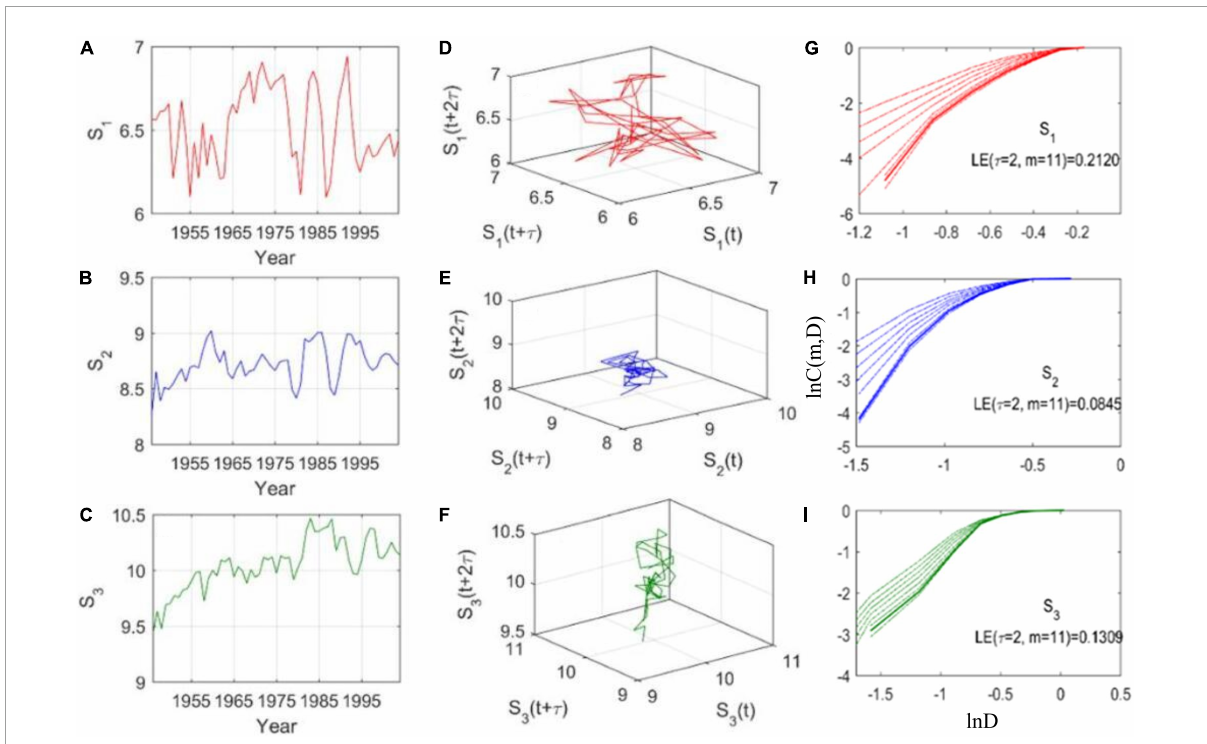
FIGURE1 Phase space reconstruction of single time series of body length. (A–C) Empirical data of body length; (D–F) Attractor reconstruction ( τ = 2; based on the C–C method) of empirical data with noise; (G–I) Lyapunov exponent (LE) of body length: D is the neighborhood radius, m is the embedding dimension, and C is the correlation integral, which is influenced by both D and m . In each rectangle, m varies from 5 to 12 (from top line to bottom line, m = 11 can be obtained for each case when the rate of change of ln C ( m , D ) with ln D does not change with the increase